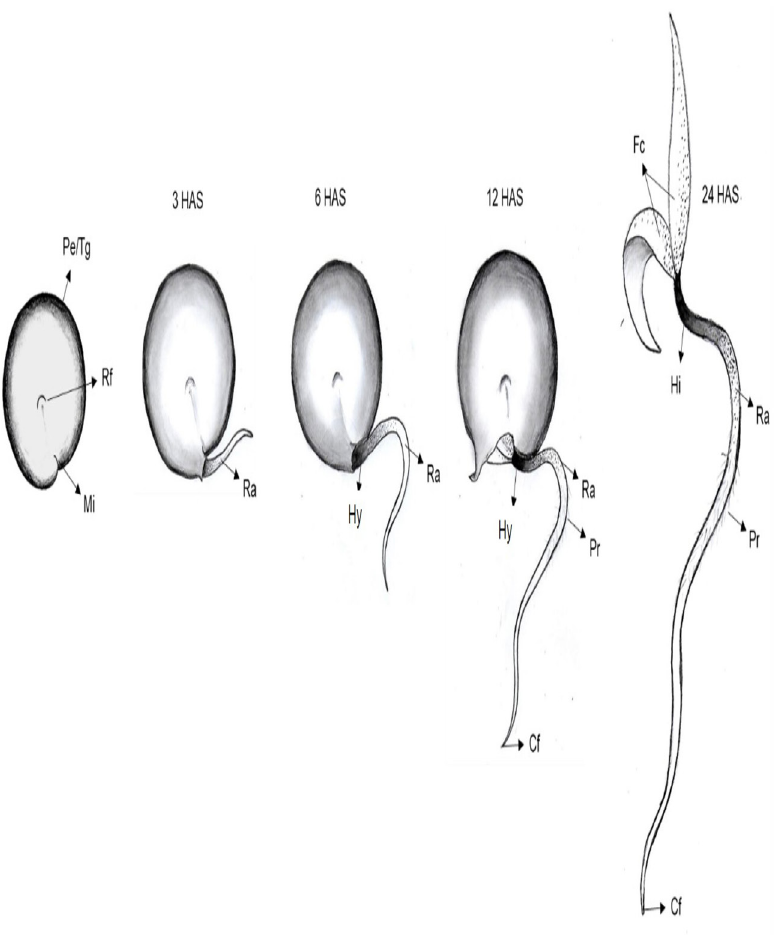
Figure 3. Morphological characterization